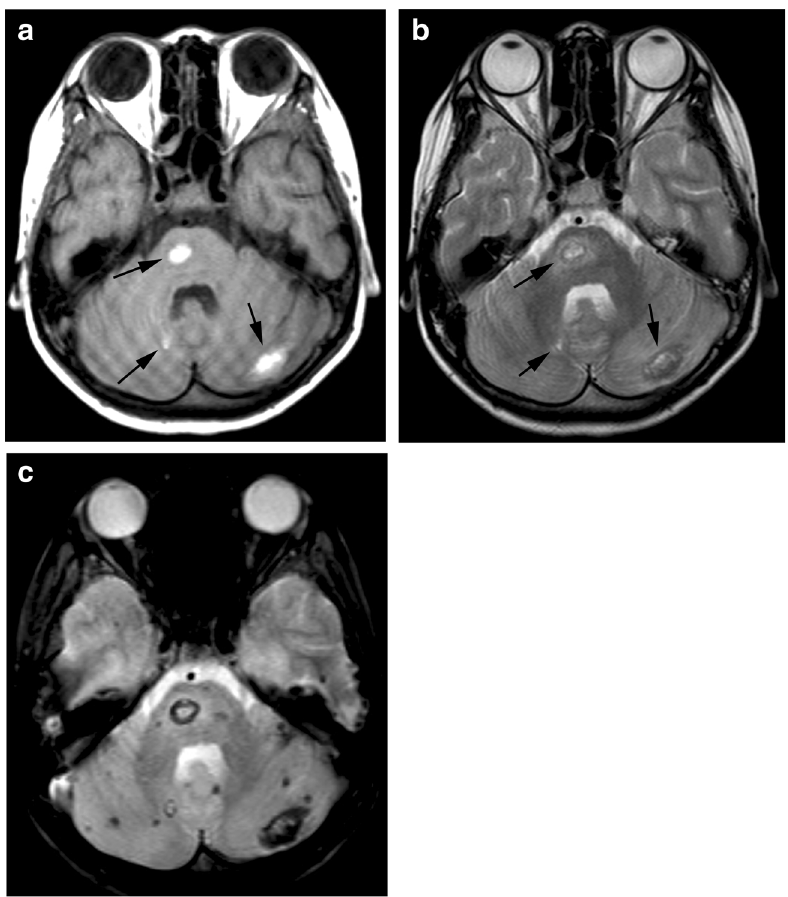
Fig. 2 Hyperviscosity syndrome. A 10-year-old girl with acute lymphocytic leukaemia, whose white blood cell count reached 400,000, presented with headache and vomiting. a AT1-weighted image shows hyperintensity in the pons and bilateral cerebellar hemispheres ( arrows ). b These lesions show hyperintensity with a hypointensity rim on T2- weighted image ( arrows ), indicating haemorrhage in the subacute phase. c T2*-weighted image demonstrates a number of microhaemorrhages which are not seen on T1- and T2-weighted